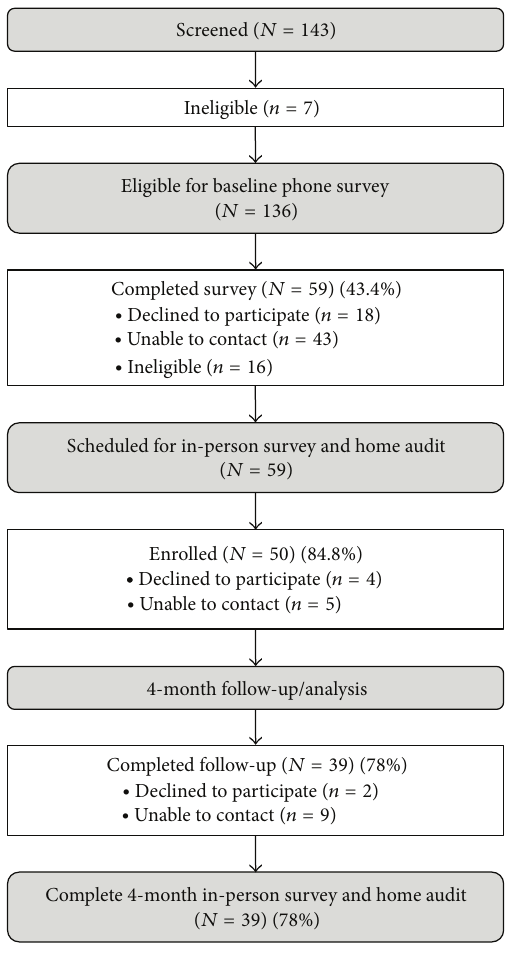
Figure 2: Healthy homes, healthy families intervention recruitment flow